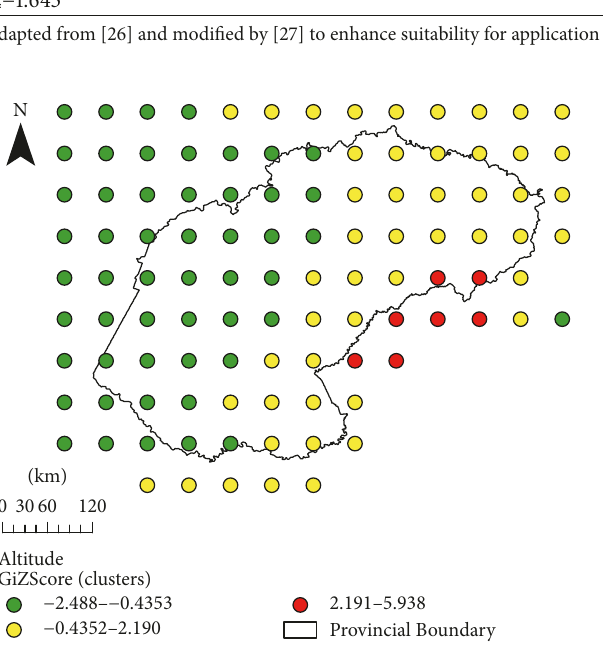
Figure 2: Locations of clusters in the Free State Province (Cluster 1 (green), Cluster 2 (yellow), and Cluster 3